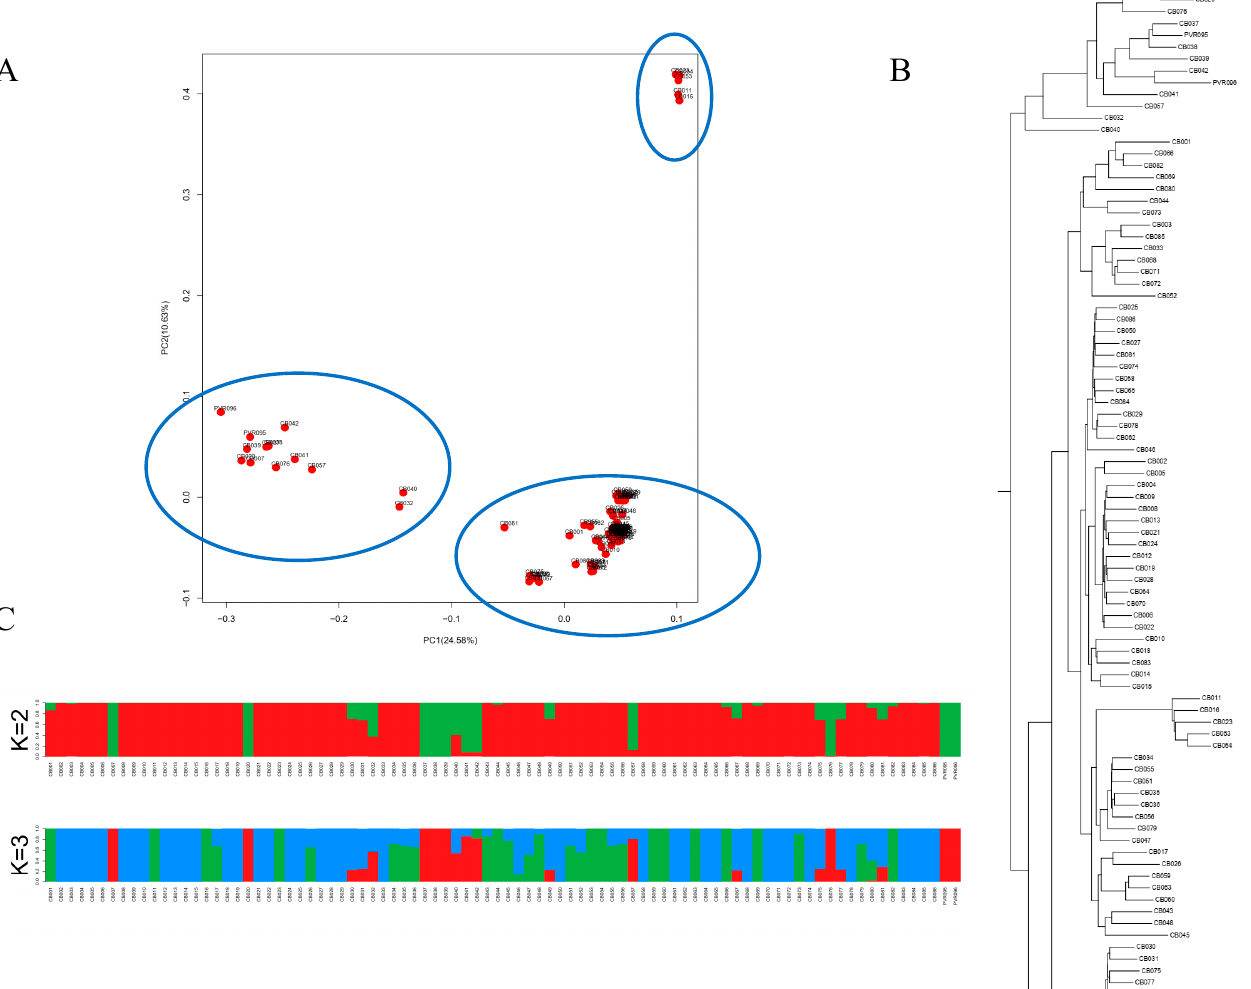
Figure 3. Population structure of the diversity panel. ( A ) PCA analysis calculated in the panel; ( B ) an unrooted neighbor-joining tree showing the dendrogram of all accessions; ( C ) estimated population structure of the panel inferred at K = 2 and K = 3.